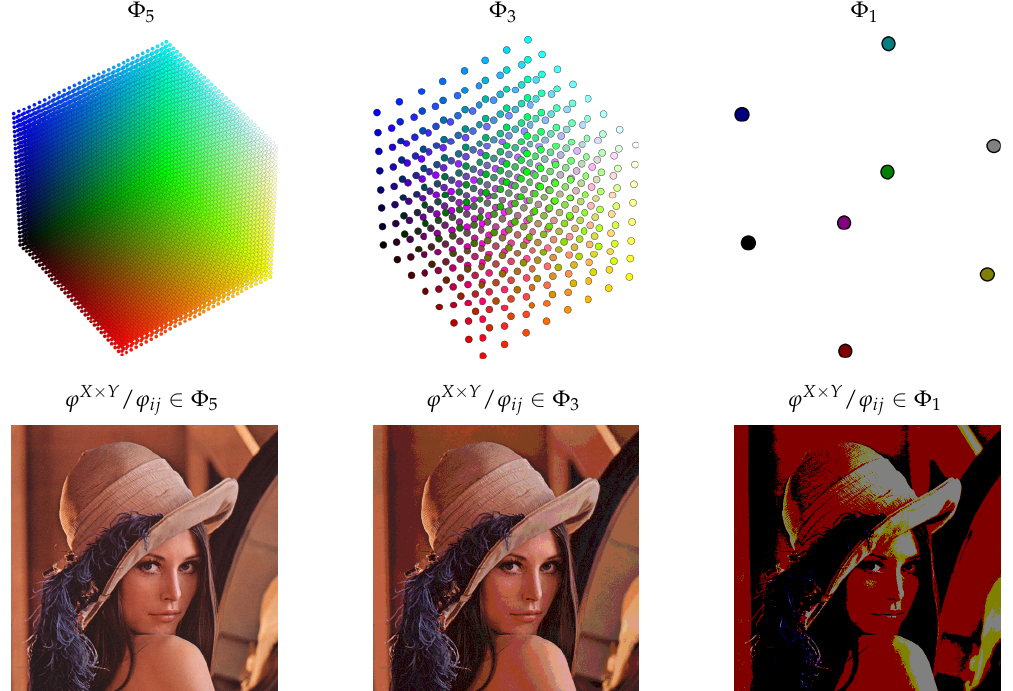
Figure 3. Example of RGB color domain reduction. Components of color coded with 5, 3 and 1